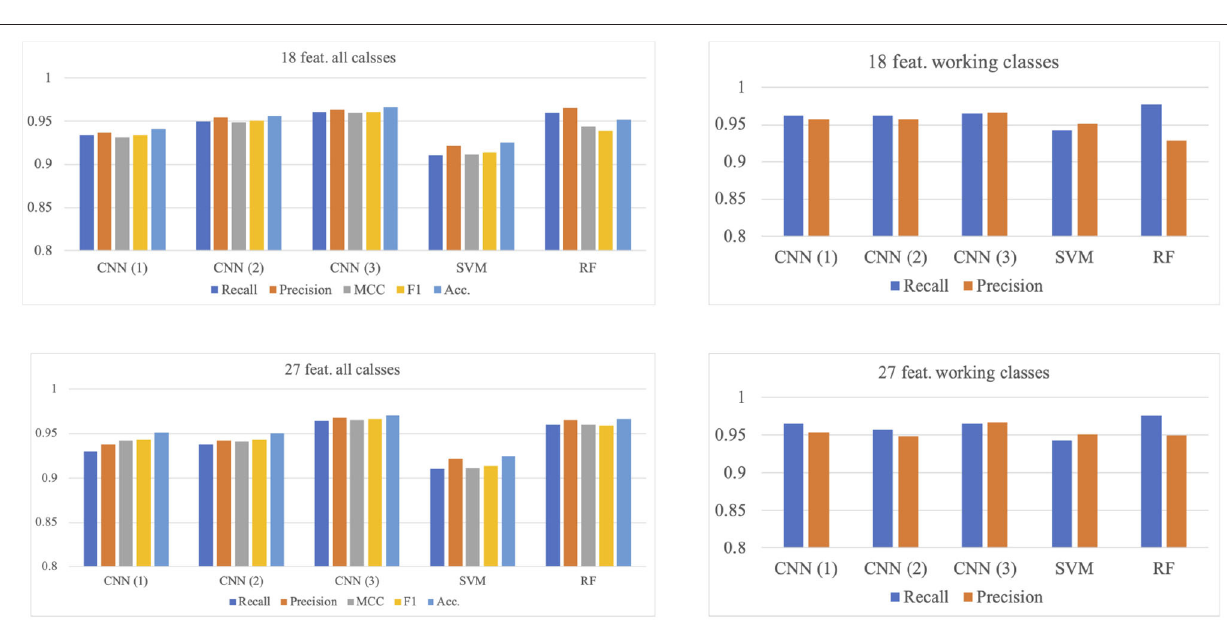
FIGURE 4 | Models comparison of 5-fold cross-validation. CNN(1), CNN(2), and CNN(3) correspond to the model with 1, 2, and 3 convolutional layer(s),